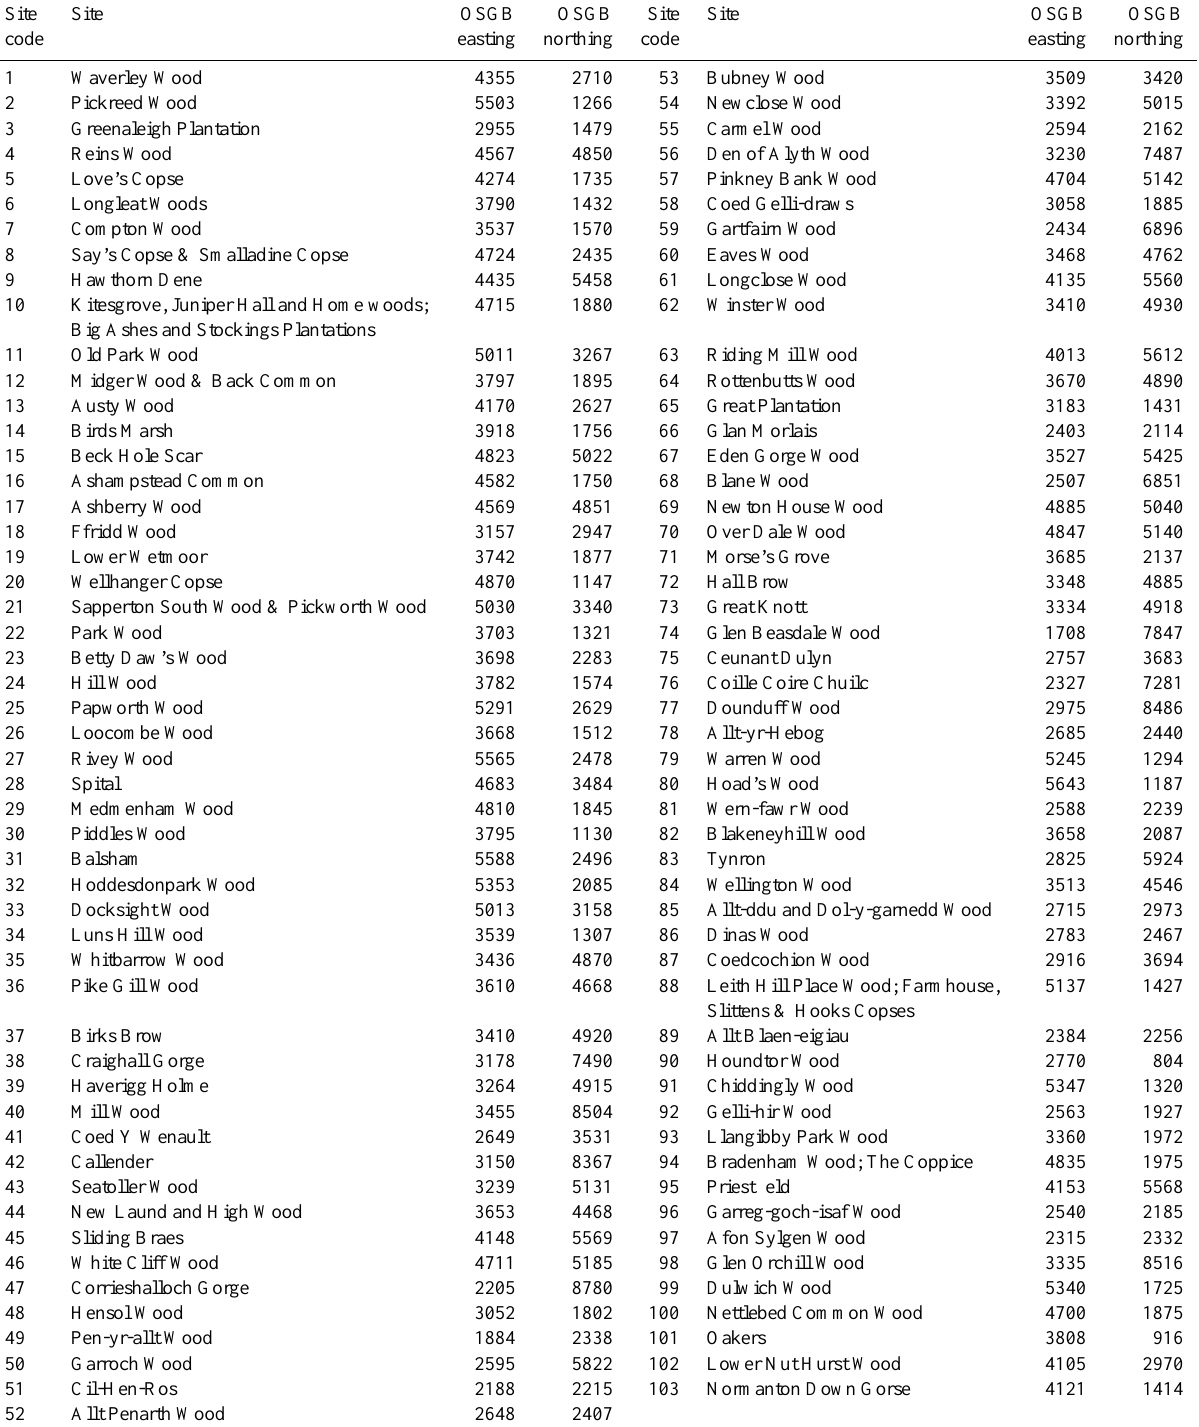
Table 1. List of the 103 woodland